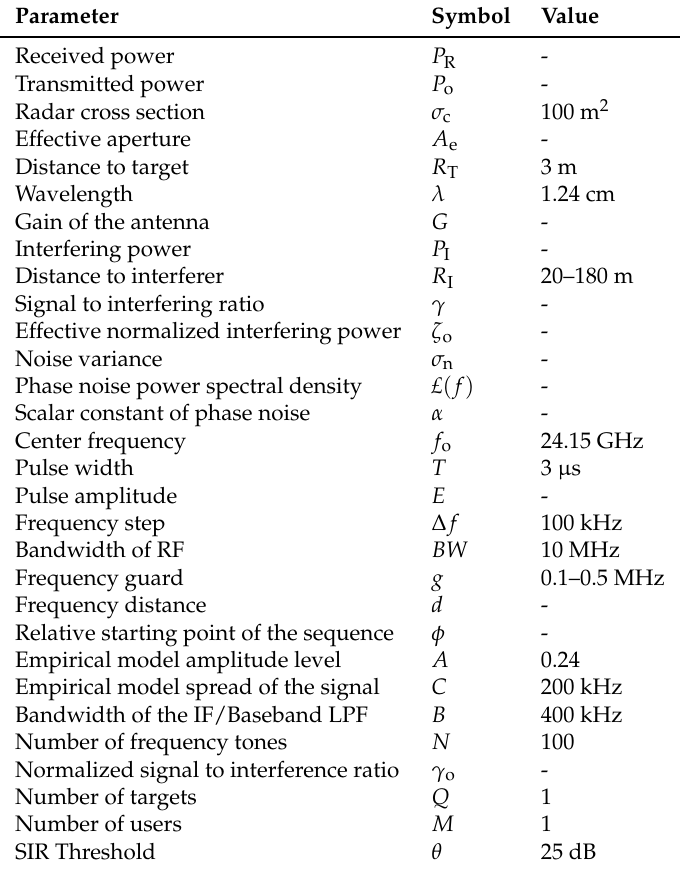
Figure 14. The empirical model in Equation (12) compared with the experimental results and the analytic Lorentzian model. Table 4. Notations and